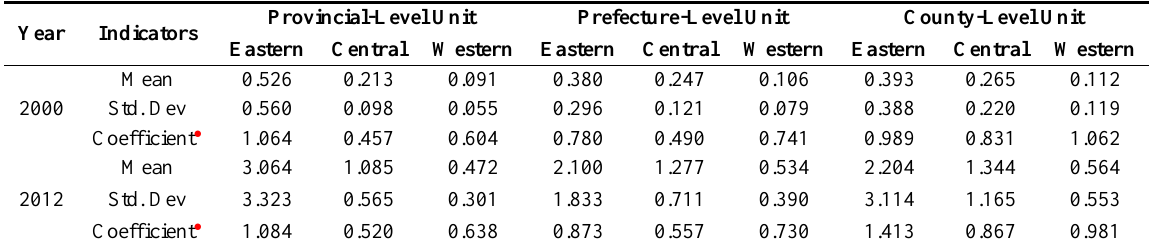
Table 3. Difference in the spatial field of administrative units at various levels in the three regions of